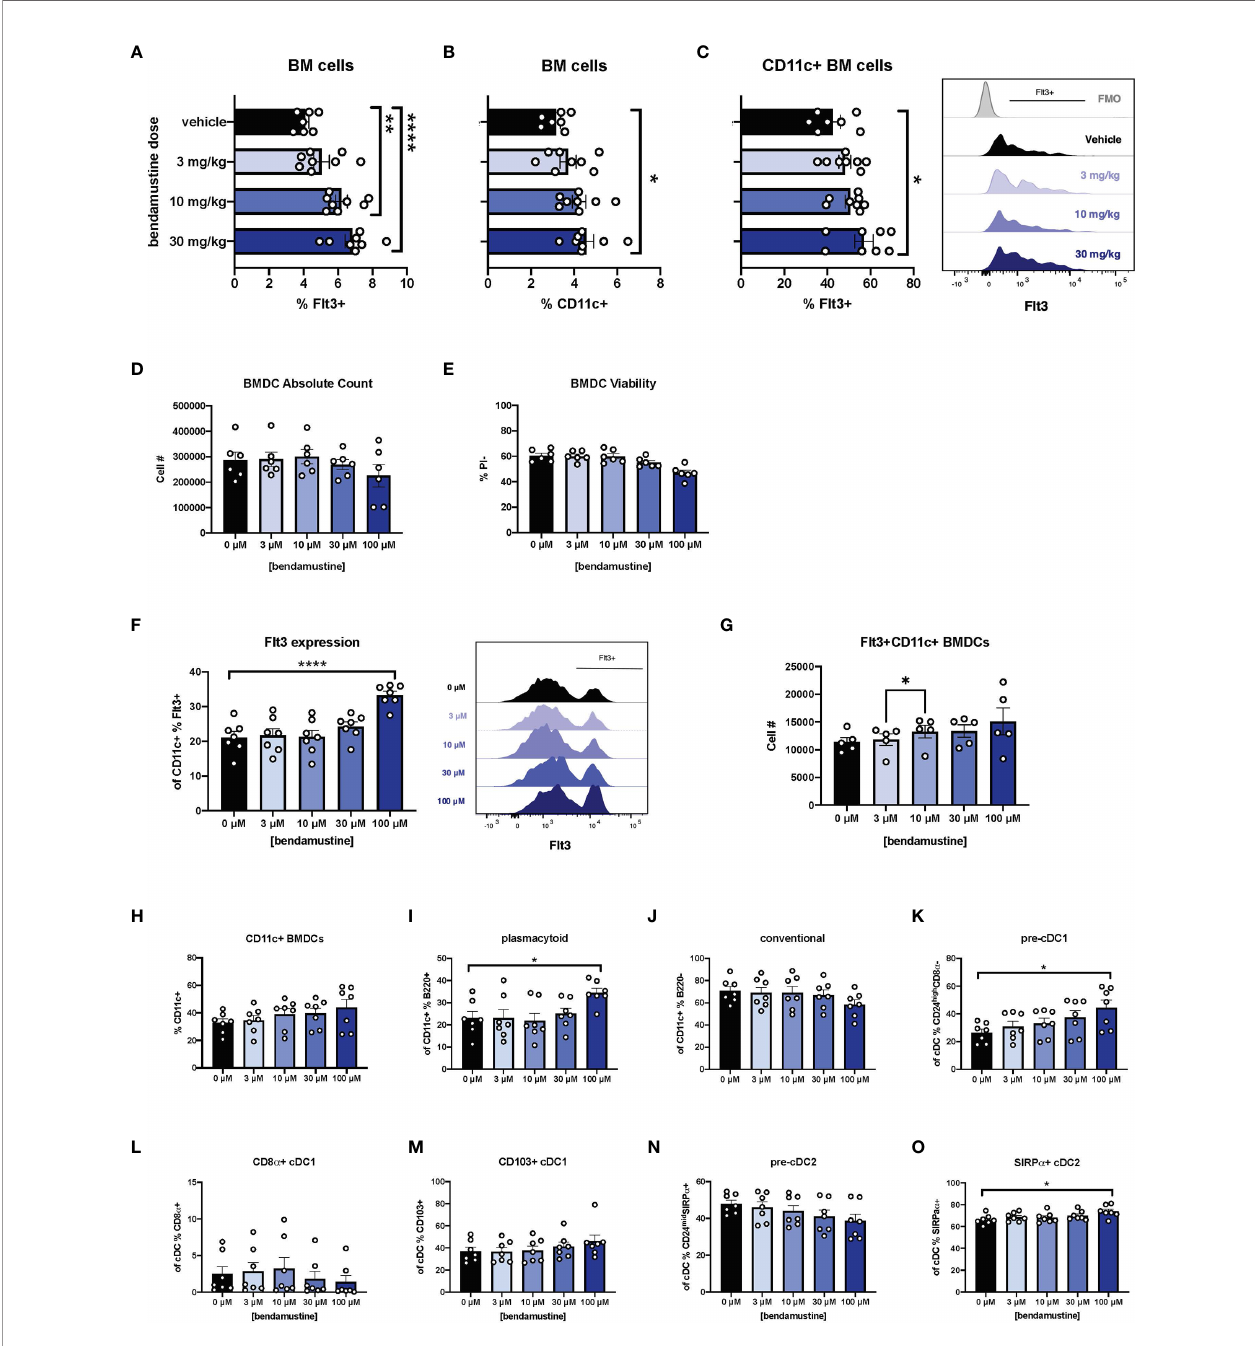
FIGURE 1 | Dose-dependent and concentration-dependent increases in Flt3 expression and skewed DC composition of murine DCs exposed to BEN. (A – C) BALB/c mice were i.v. injected with various doses of bendamustine or vehicle and bone marrow (BM) was harvested 48 hours later for analysis by fl ow cytometry. Data is pooled from 3 independent experiments (n=7-8). (A) Mean percent Flt3 expression on total BM cells is shown with SEM. (B) The mean percentage of CD11c + DCs within bone marrow is shown with SEM. (C) Among CD11c + DCs within bone marrow, mean percent Flt3 expression is shown with SEM. Representative histogram shown (right) with Fluorescence Minus Once (FMO) control. (D – N ) BALB/c FL-BMDCs were generated following brief exposure to BEN and characterized by fl ow cytometry. Data is pooled from 3 independent experiments (n=6-7). (D) Mean absolute cell number and (E) percent viable (Propidium Iodide-) cells are shown with SEM. (F) Mean percent Flt3 expression among CD11c + FL-BMDCs is shown with SEM (left) and representative histograms (right). (G) Mean absolute cell number of Flt3 + CD11c + FL-BMDCs is shown with SEM. (H – N) Mean percent with SEM of murine DC lineages including (H) total CD11c + , (I) plasmacytoid DCs (CD11c + B220 + ), (J) conventional DCs (CD11c + B220 - ), (K) pre-cDC1s (CD11c + B220 - CD24 high CD8 a - ), (L) CD8 a + cDC1s (CD11c + B220 - CD8 a + ), (M) CD103 + cDC1s (CD11c + B220 - CD103 + ), (N) pre-cDC2s (CD11c + B220 - CD24 mid SIRP a + ), and (O) SIRP a + cDC2s (CD11c + B220 - SIRP a + ). One-way ANOVA and Dunnett ’ s multiple comparisons test were used to determine signi fi cance among groups. *P < 0.05, **P < 0.01, ****P <